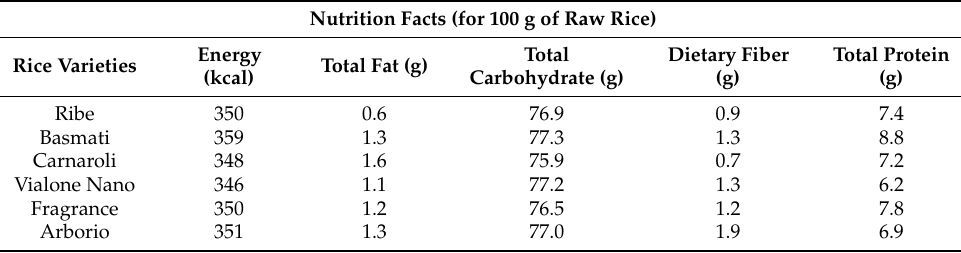
Table 1. Nutritional facts of the six selected raw rice varieties from nutritional labels.